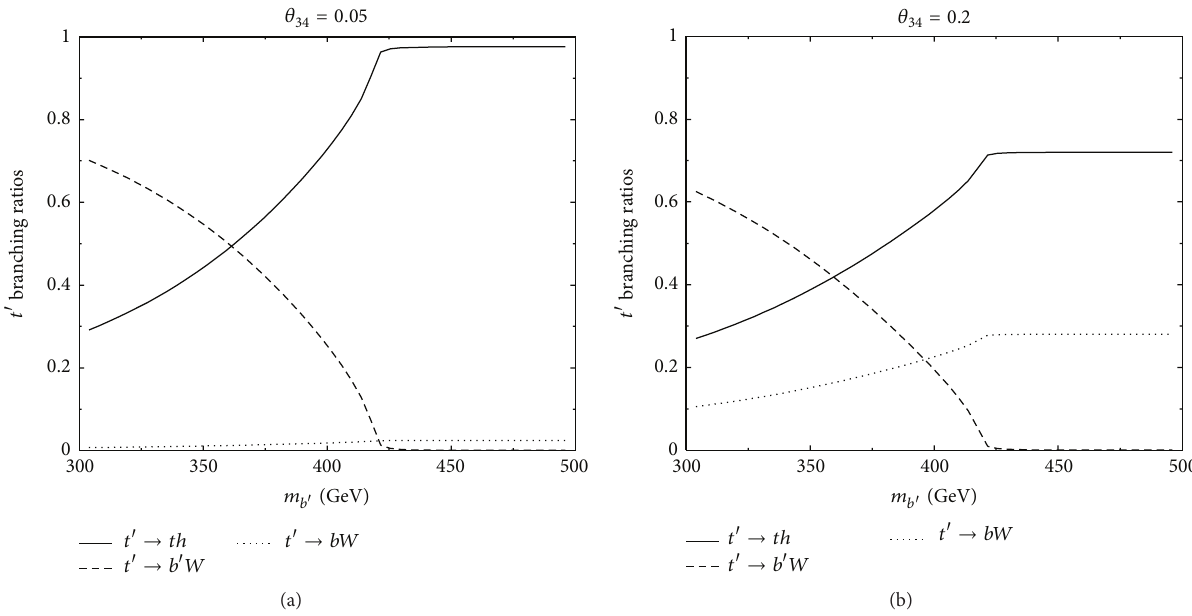
Figure 16: The branching ratios for the 𝑡 󸀠 decay channels 𝑡 󸀠 → 𝑡ℎ , 𝑡 󸀠 → 𝑏𝑊 , and 𝑡 󸀠 → 𝑏 󸀠 𝑊 (⋆) ( 𝑊 (⋆) are either on shell or off shell depending on the 𝑏 󸀠 mass) in the 4G2HDMI, as a function of 𝑚 𝑏 󸀠 , for 𝑚 ℎ = 125 GeV, 𝑚 𝑡 󸀠 = 500 GeV, 𝜖 𝑡 = 𝑚 𝑡 /𝑚 𝑡 󸀠 , tan 𝛽 = 1 , 𝜃 34 = 0.05 (a), and 𝜃 34 = 0.2 (b). Also, 𝛼 = 𝜋/2 , and 𝑚 𝐻 + > 𝑚 𝑡 󸀠 , 𝑚 𝐴 > 𝑚 𝑡 󸀠 are assumed.